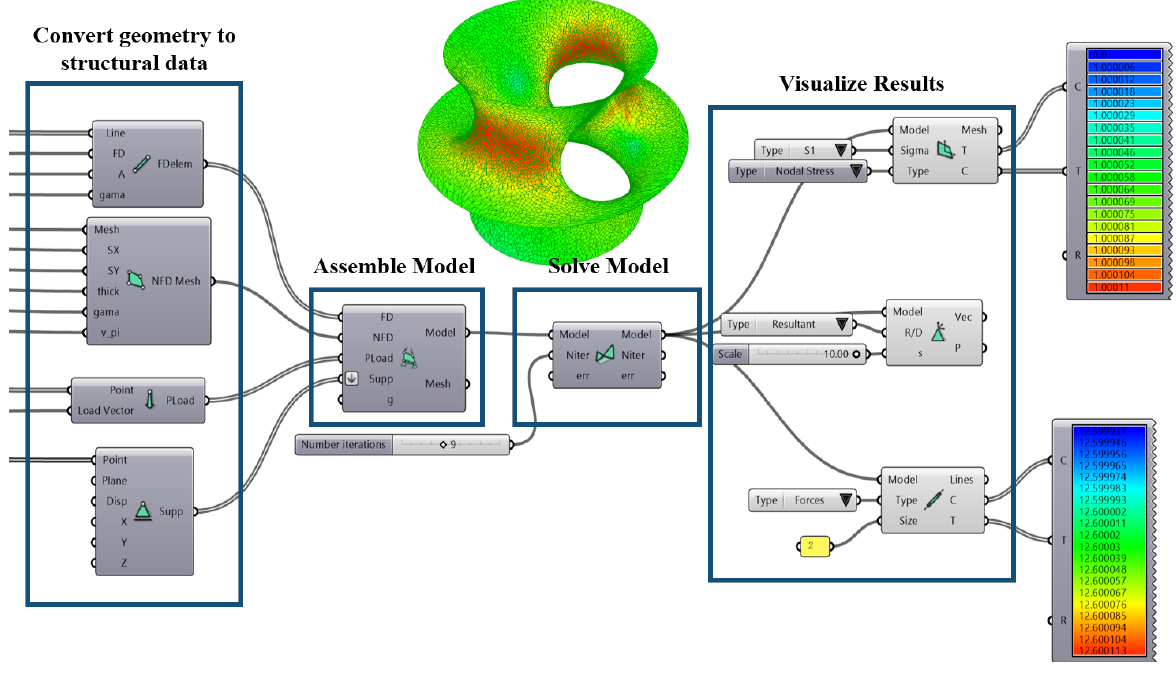
Figure 8: BATS components and